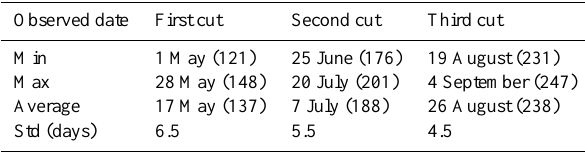
Table 1. Main statistics of mowing dates collected for 120 fields (Std: standard deviation, DOY: Day Of Year from the 1